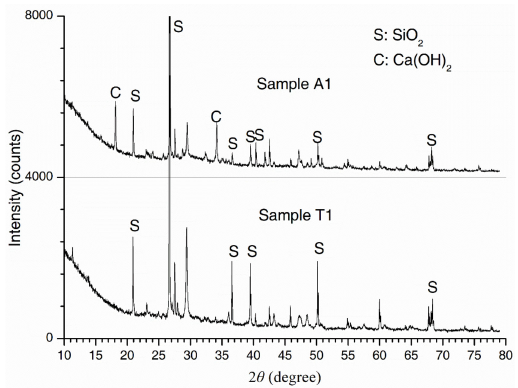
Figure 4. XRD spectra of concrete